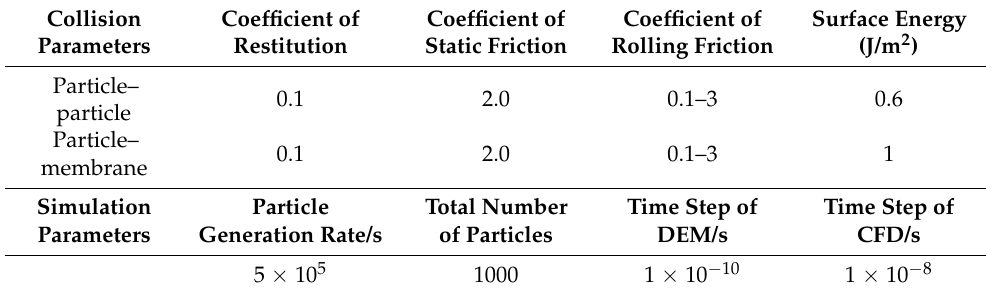
Table 2. Collision and simulation parameters